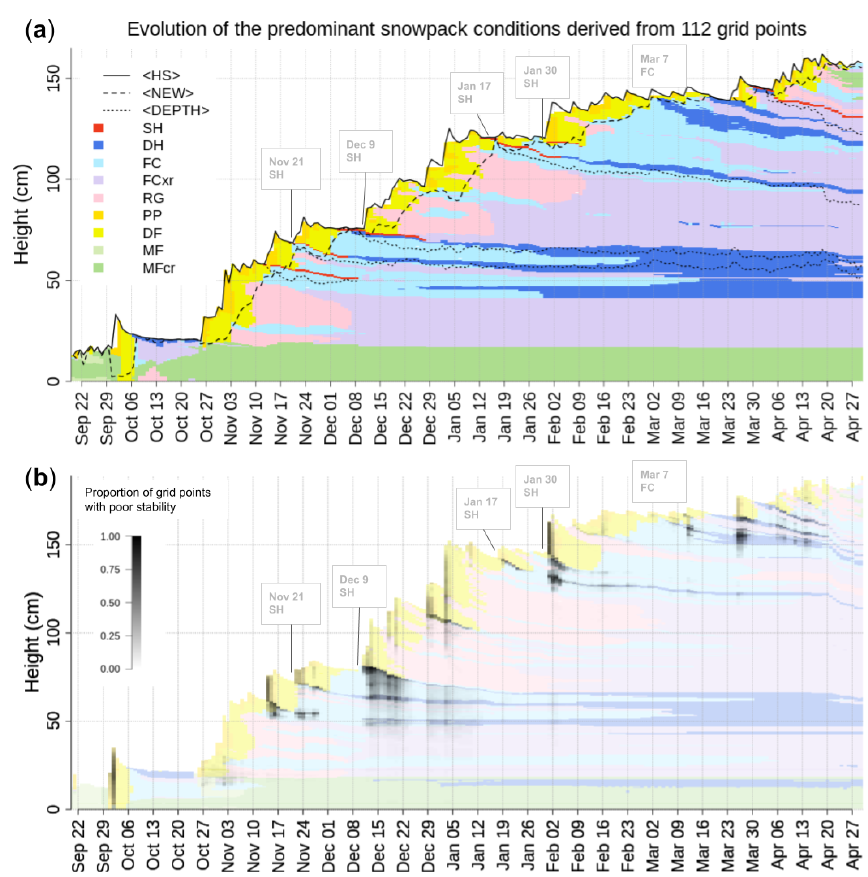
Figure 4. (a) Time series of the average snow profile that illustrates the space-averaged evolution of the snow stratigraphy (visualized by snow grain types). The algorithm captures the median total snow height (solid line, (cid:104) HS (cid:105) ), the median amount of new snow (dashed line, (cid:104) NEW (cid:105) ), and the median depth of several persistent weak layers (dotted lines, (cid:104) DEPTH (cid:105) ). (b) The time series of the average profile overplotted with the distribution of grid points that contain layers with poor stability as diagnosed by p_unstable (Mayer et al., 2022); it is therefore the analogon to Fig. 3e in a time series